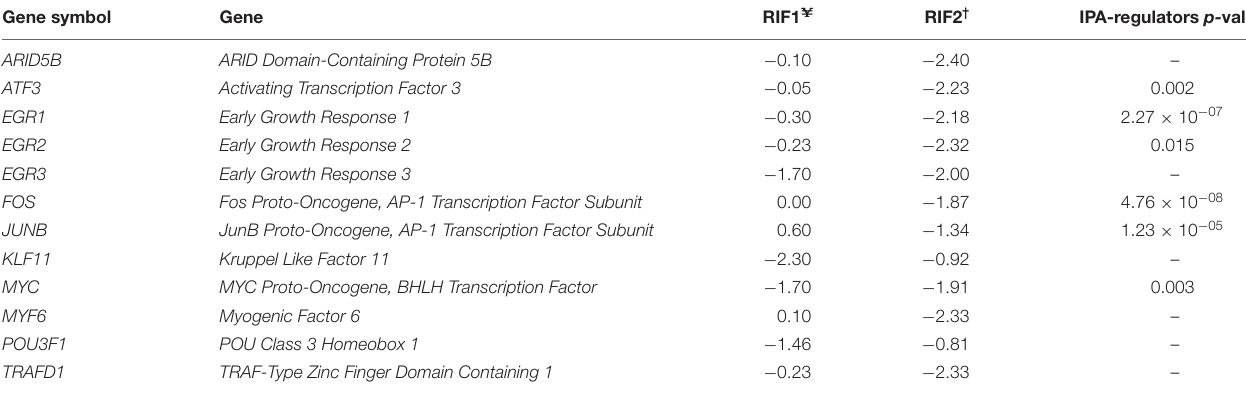
FIGURE 7 | Network of the co-expression between hub lncRNAs and protein-coding genes in the blue (A) and turquoise (B) modules. TABLE 6 | Potential regulators affecting gene expression of DE genes between H and L groups, identified by RIFs study and IPA software. Gene symbol